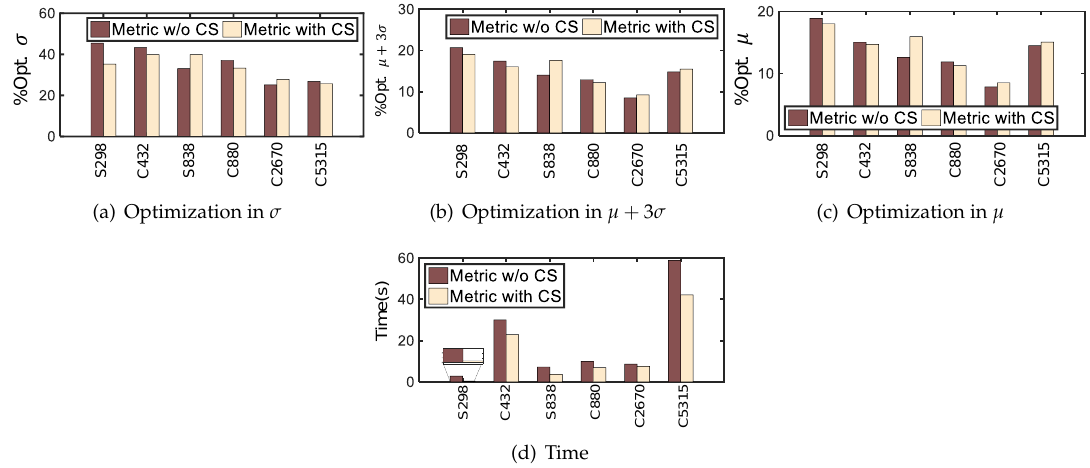
Figure 6. Benefit in computing time using the coarse selection simple metrics (CS).